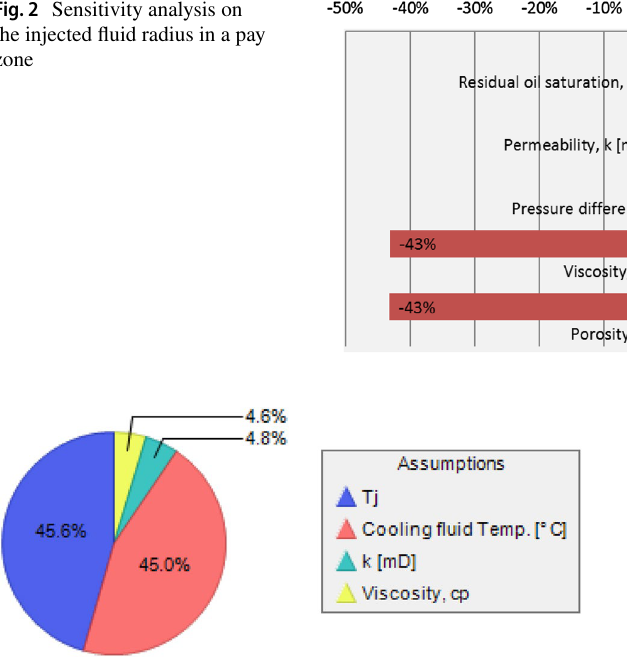
Fig. 2 Sensitivity analysis on the injected fluid radius in a pay zone